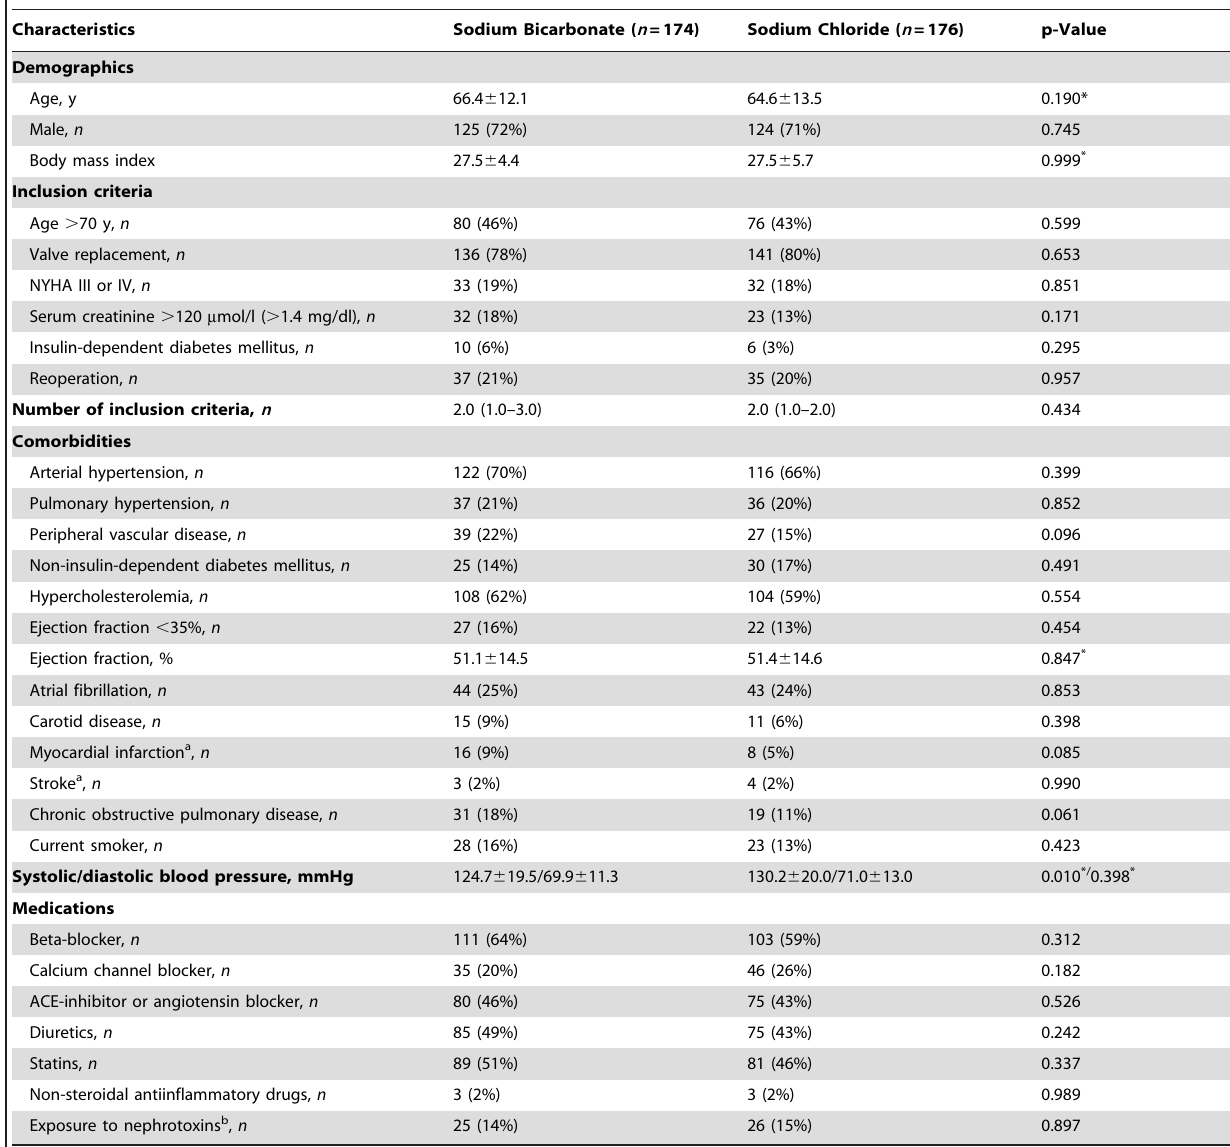
Table 1. Preoperative characteristics.